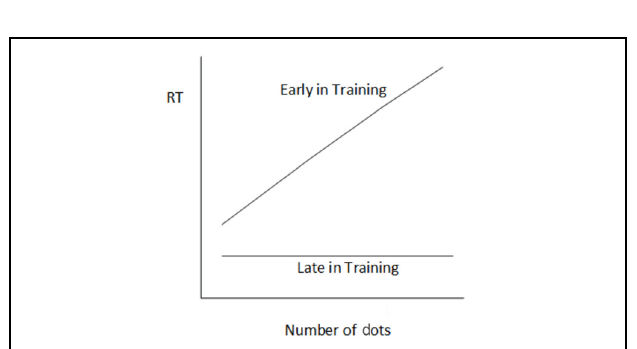
FIGURE 1 | An example of the type of dot picture used by Lassaline and Logan (1993). Subjects are asked to indicate the number of dots in the picture.